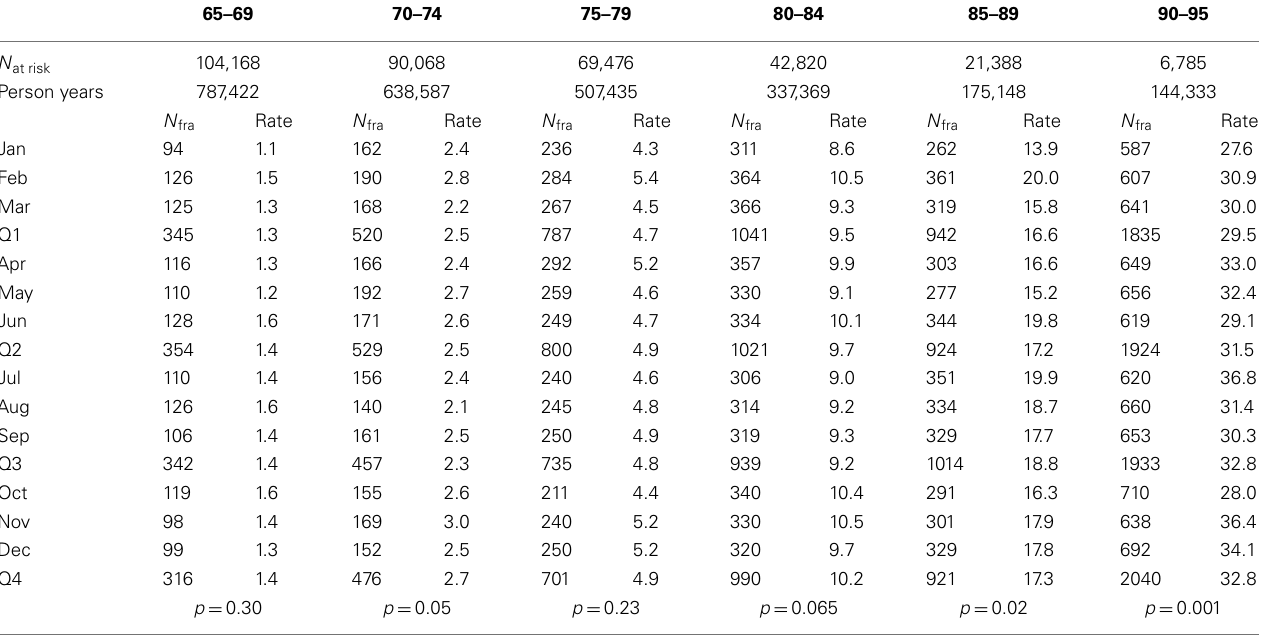
Table 2 | Hip fractures in